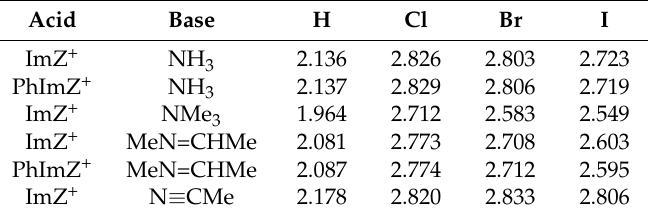
Figure 1. Optimized geometry of ( a ) ImH + and ( b ) its phenyl derivative with NH 3 ; and ( c , d ), their I-substituted analogues. Distances in Å and angles in degs. Table 1. Optimized R(N ··· Z) intermolecular distance (Å) of substituted imidazoliums with N-bases.